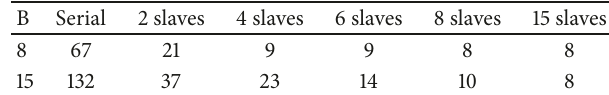
Table 6: Comparison of the computational